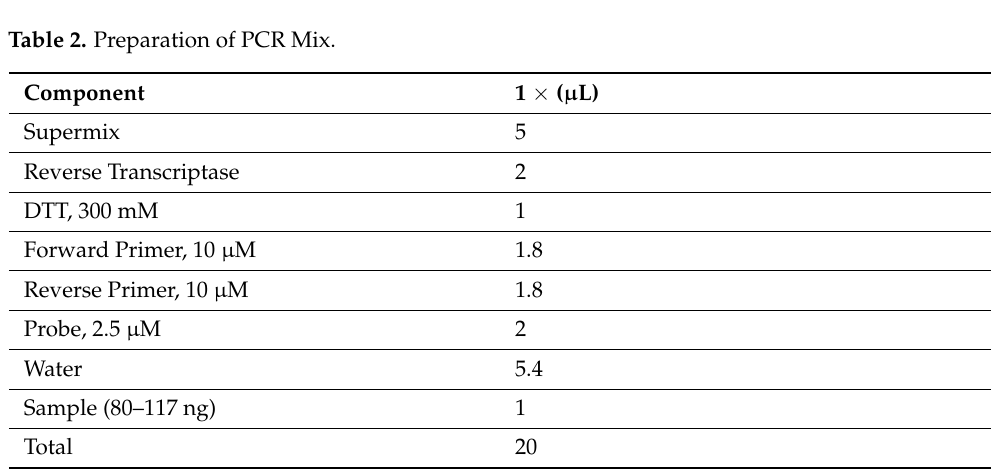
Table 2. Preparation of PCR Mix.